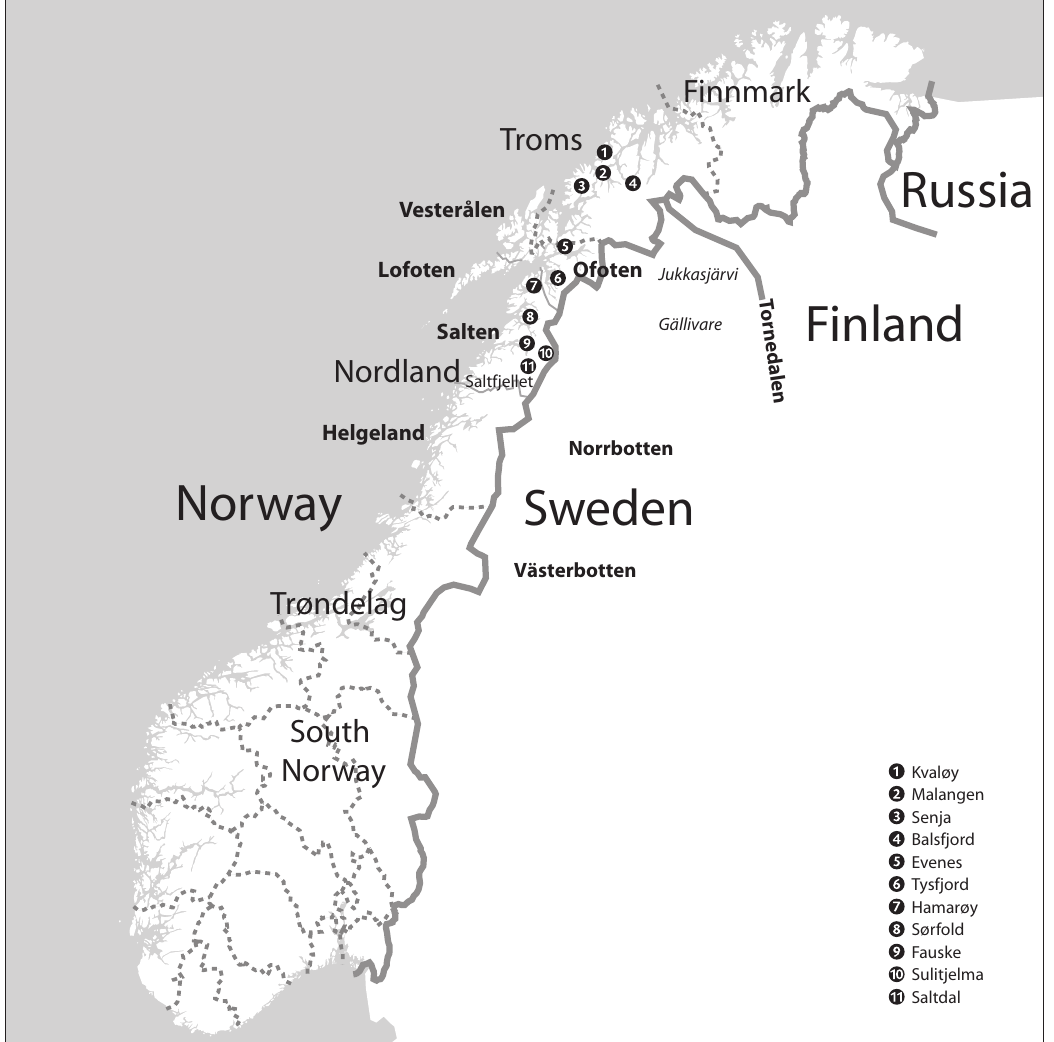
Fig. 1. Map with the place names (toponymes) used in the